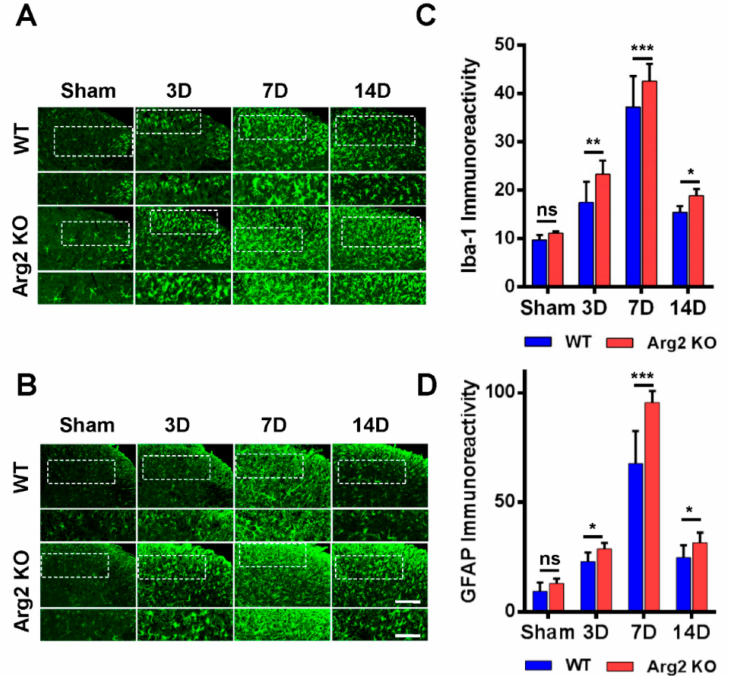
Figure 4. Robust microgliosis and astrogliosis were observed in the spinal cords of mice following SNT surgery. ( A , B ) Representative immunohistochemical staining images of spinal cord sections from mice on days 3, 7, and 14 post-surgery using Iba-1 (a microglial marker) and GFAP (glial fibrillary acidic protein, an astrocyte marker) antibodies. Microglia and astrocytes were activated in the spinal cords of SNT WT ( n = 3) and Arg2 KO ( n = 3) mice but were most robust in the Arg2 KO mice. The lower panel displays the images with higher magnification of the upper panel. Scale bar = 100 µ m (upper panel) and 50 µ m (lower panel). ( C , D ) Immunodensities of Iba-1- and GFAP-positive cells. Immunodensities in the graphs were quantified by the Image J program. Data are presented as means ± SEM (two-way ANOVA with Tukey’s post hoc test, F (7,16) = 37.88 (C), F (7,16) = 7.81 (D), *** p < 0.001, ** p < 0.01, and * p < 0.05 versus WT, ns: